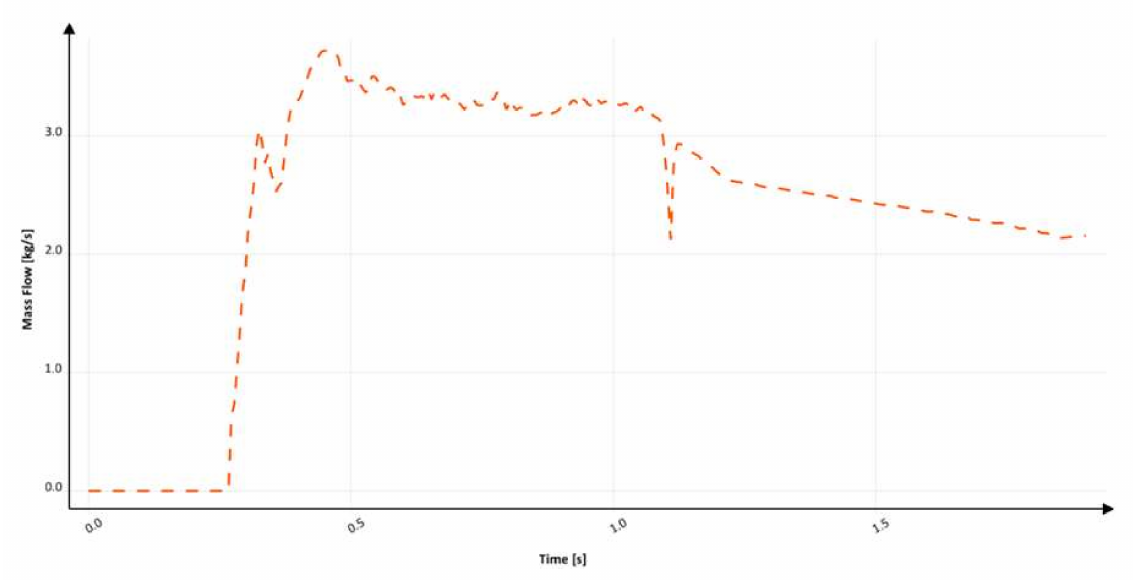
Figure 18. Mass flow through ingate with round, non-tapered sprue (S s 1),